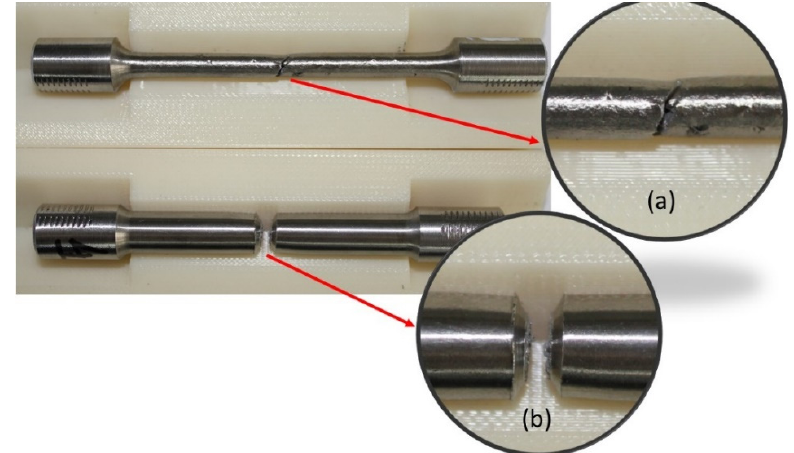
Figure 8. Comparison of the failure mode of stress-relieved smooth ( a ) and V-notched specimens with a notch root radius of 0.05 mm ( b ).